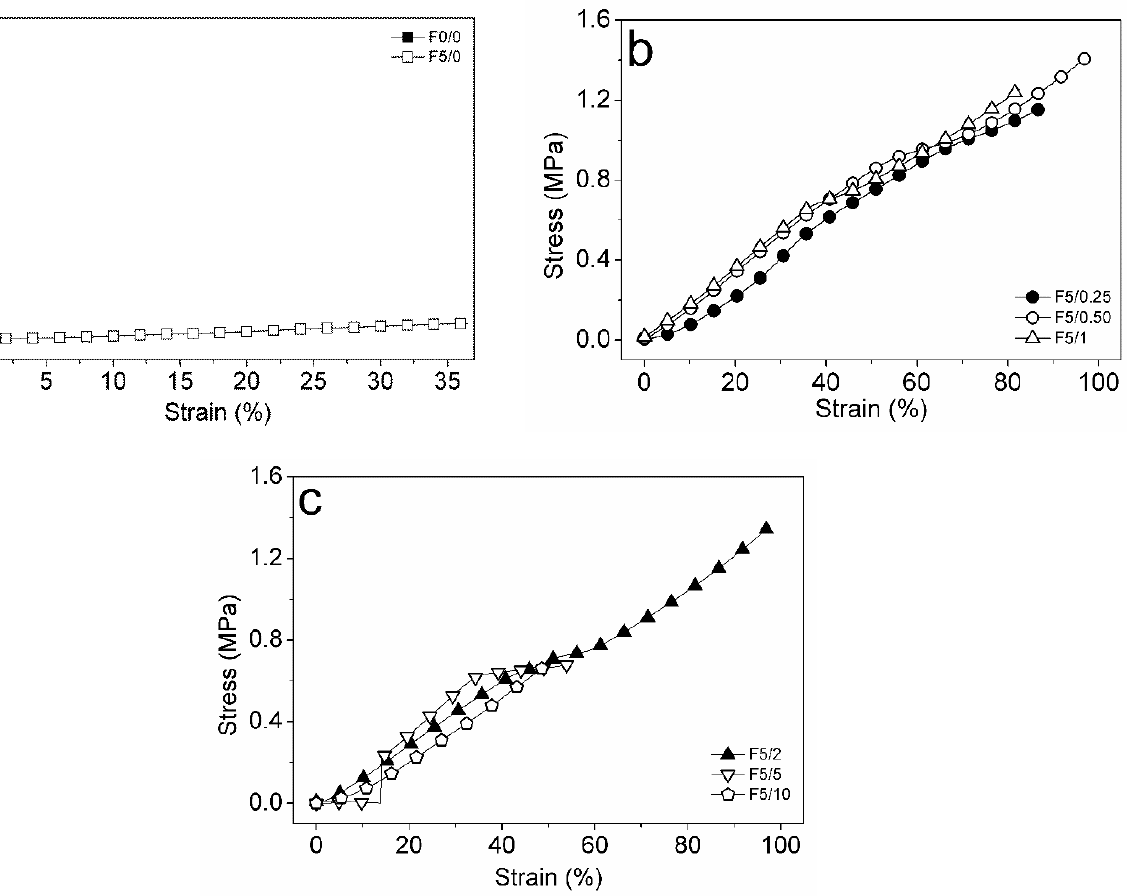
Figure 6. Stress versus strain curves for films: ( a ) F0/0 (full squares) and F5/0 (open squares); ( b ) F5/0.25 (full circles), F5/0.5 (circles), F5/1 (triangles); ( c ) F5/2 (full triangles), F5/5 (inverted triangles) and F5/10 (lozenges).